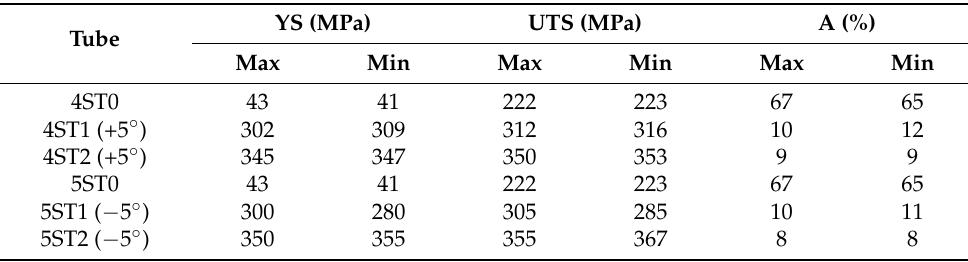
Table 6. Tensile properties of the Cu tubes before and after drawing with a tilted die. Three tests were performed in each case. Deviation <1.5% for YS and UTS, <3% for the elongation to rupture. YS (MPa) Tube